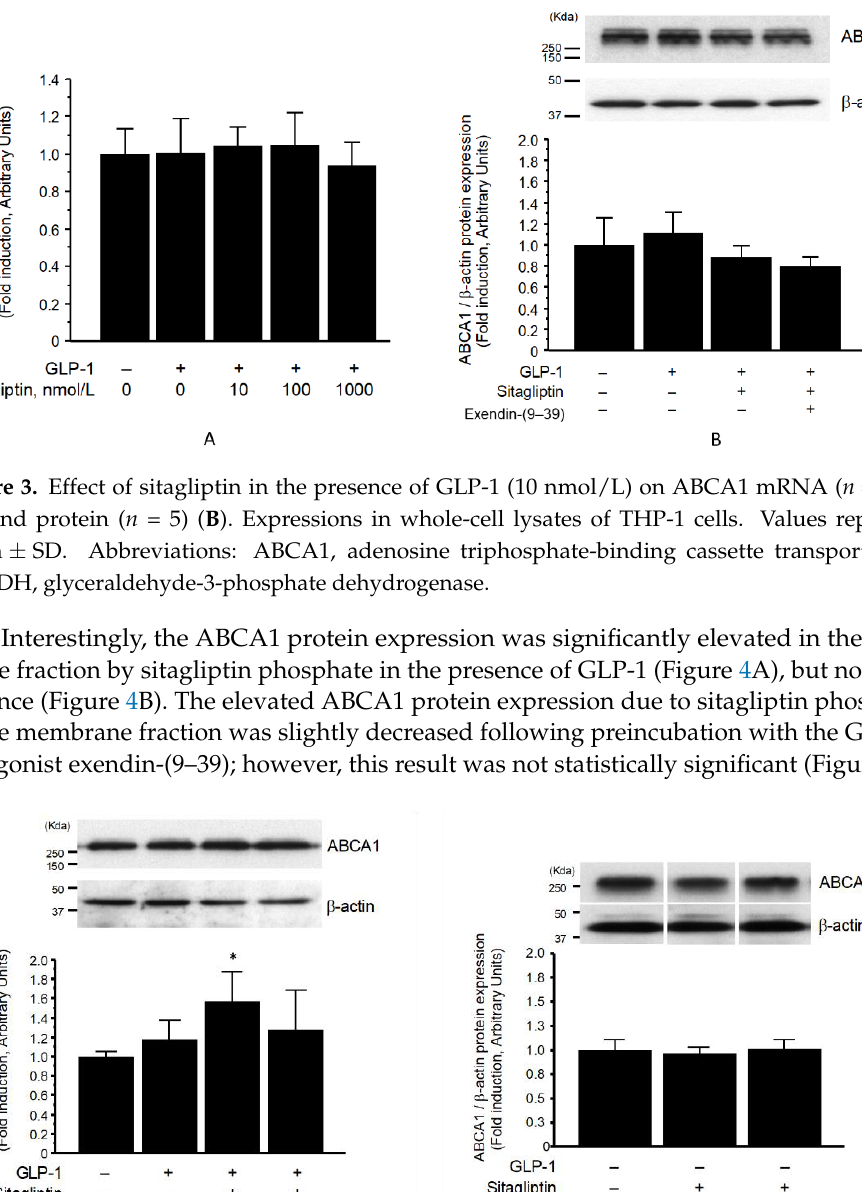
Figure 2. Effect of sitagliptin and vildagliptin in the presence of GLP-1 (10 nmol/L) on apoA1-medi- ated cholesterol efflux. Values represent mean ± SD. * p < 0.05 vs apoA-I + GLP-1, † p < 0.05; ‡ p < 0.01 vs . sitagliptin (100 nmol/L). Each group, n = 4 – 8.